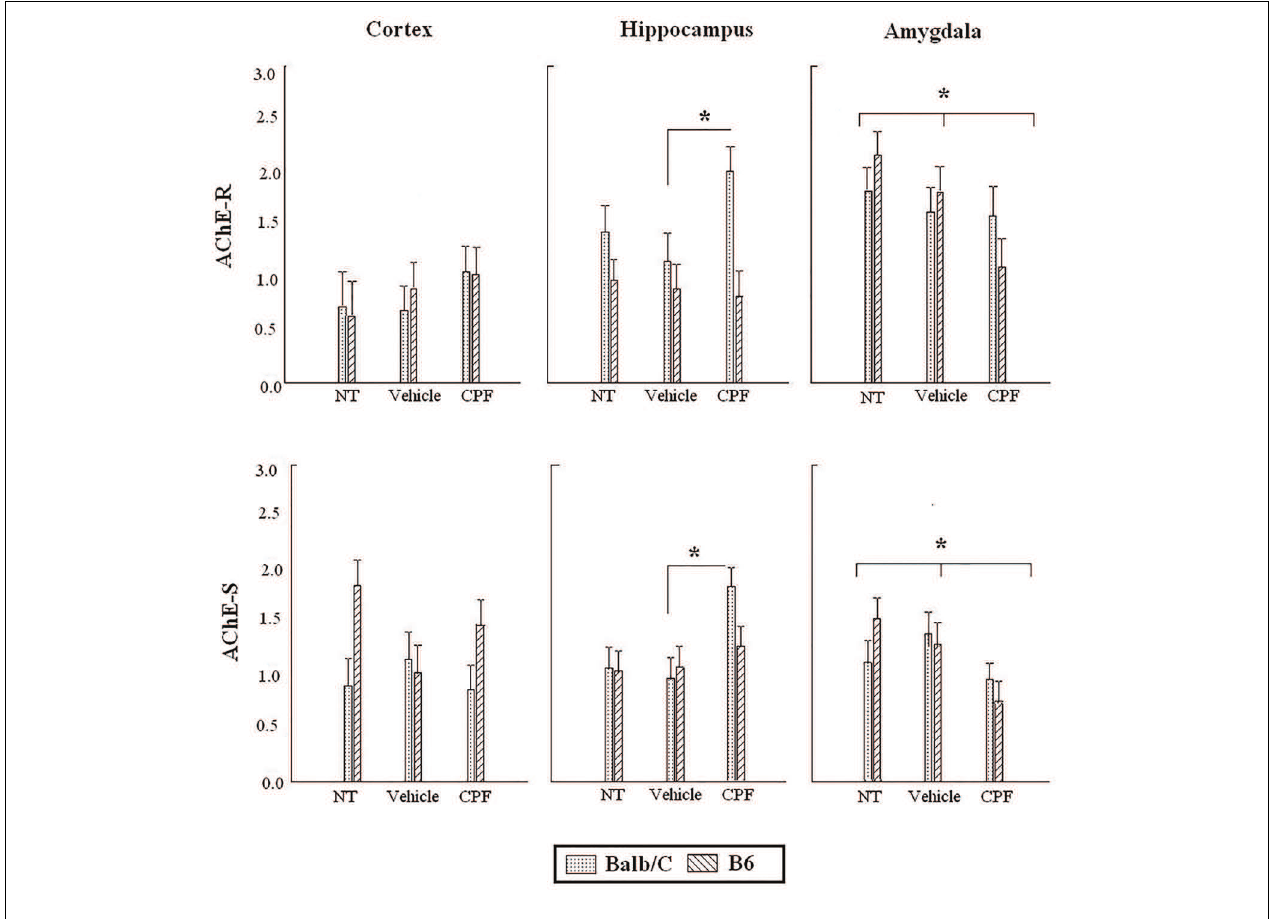
FIGURE 5 | Expression of AChE-R and AChE-S in adult brain regions following cued fear conditioning. Data are mean ( ± )SEM of AChE-R or AChE-S splice variants in the frontal cortex, hippocampus and amygdala. * p < 0 . 05 CPF vs. Vehicle in